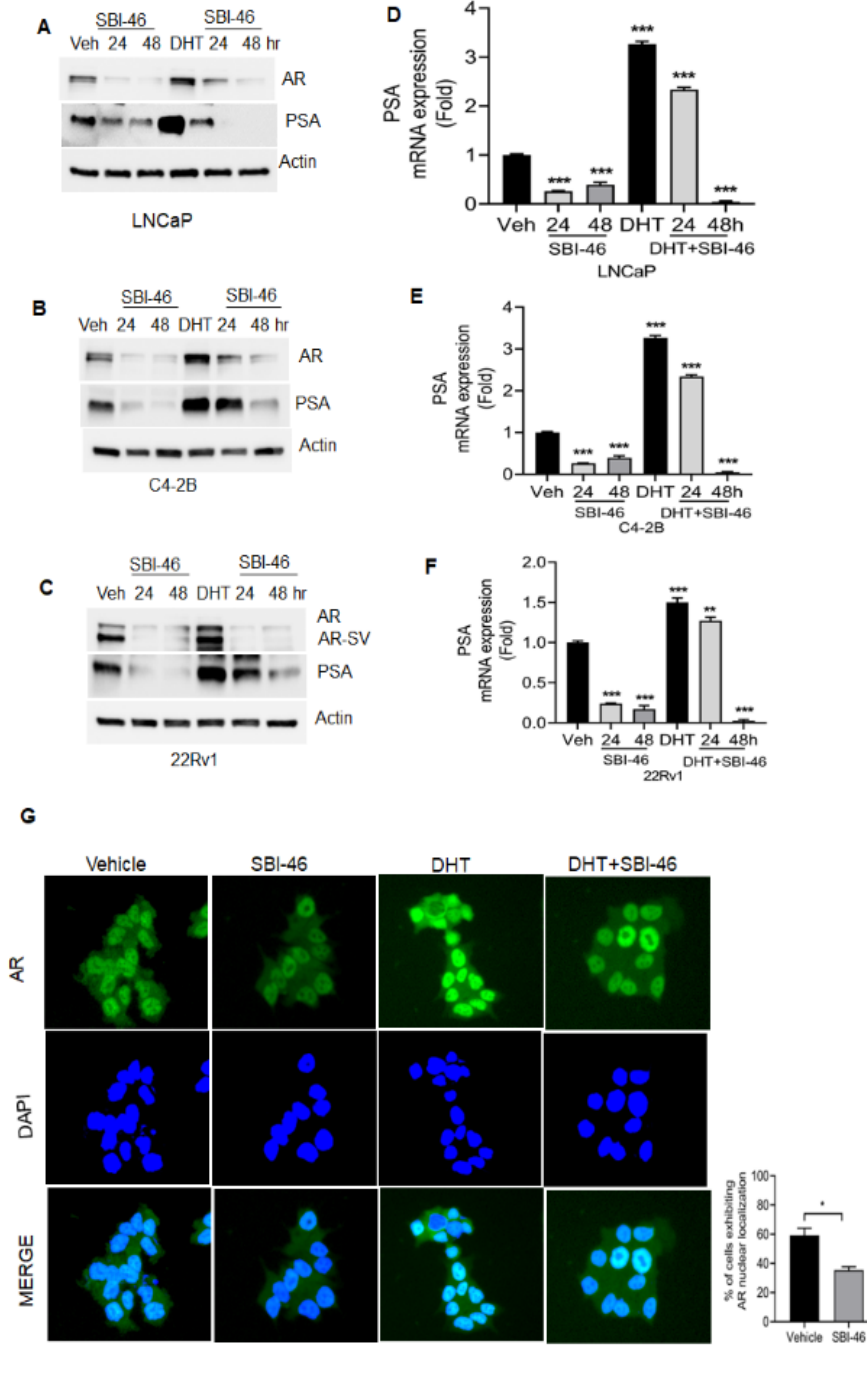
Figure 3. SBI-46 downregulates DHT-induced AR expression in CRPC cells. ( A – C ) Western blot and analysis of AR signaling in the vehicle or DHT or combination with SBI-46 in LNCaP, C4-2B, and 22Rv1 cells. ( D – F ) Real-time analysis of PSA expression in the vehicle or DHT or combination with SBI-46 in LNCaP, C4-2B, and 22Rv1 cells ( G ). Representative fluorescent images of AR expression in vehicle or DHT or SBI-46-treated 22Rv-1 cells for 24 h. Quantitative data are presented as mean ± SD. Densitometry analysis was performed with ImageJ software for the immunoblots. The p -values corresponding to various symbols used are: ( p > 0.05); * p < 0.05; ** p < 0.01, and *** p < 0.001. The uncropped blots are shown in the Supplemental Materials.